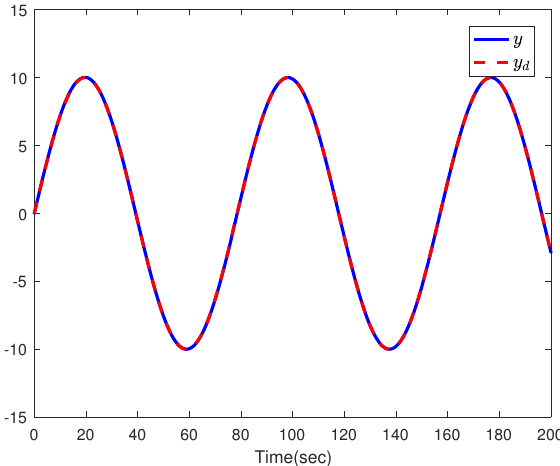
Figure 1. Tracking effect of System (3).